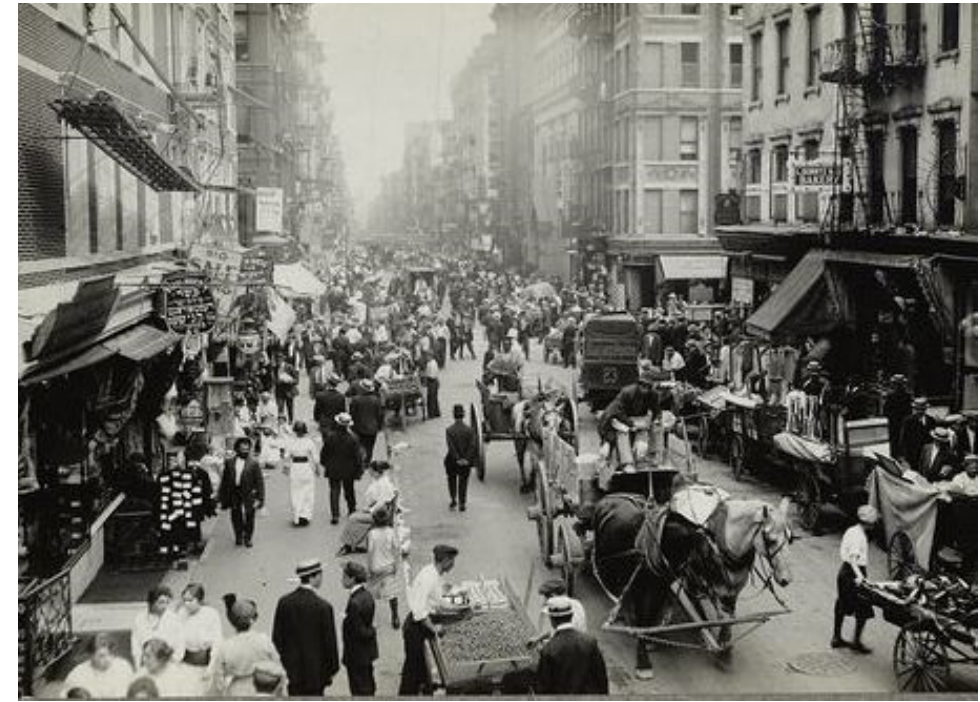
Figure 1. Lewis Hine, 1912. Market Day in Jewish Quarter of East Side, New York City. New York